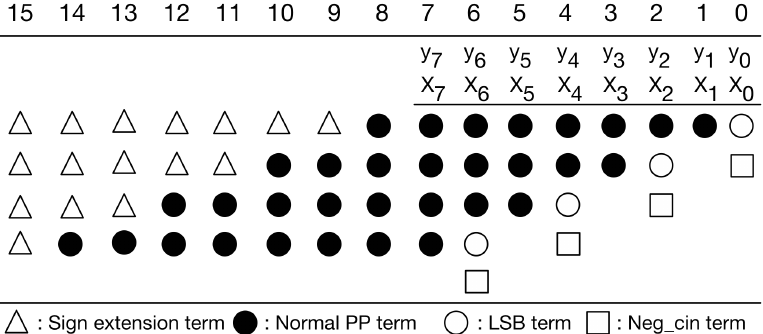
Figure 6. The typical PPM of radix-4 booth encoding.